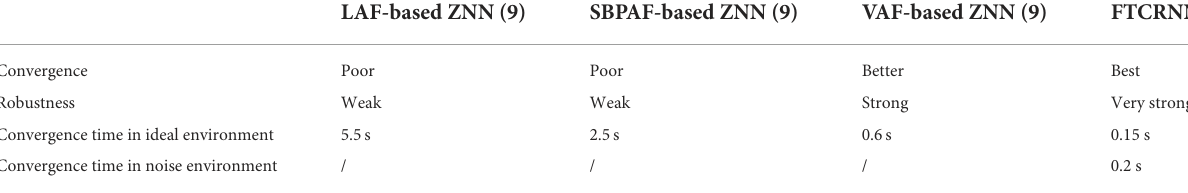
TABLE 7 Comparisons of the LAF, SBPAF, VAF, and NAF based models for solving